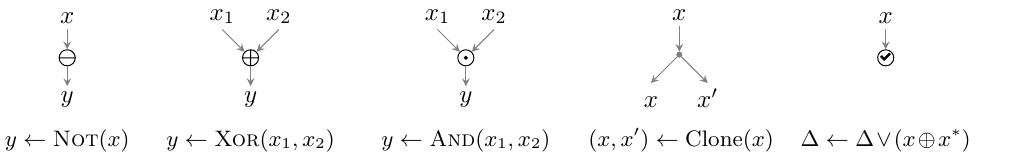
Figure 2: Nodes for basic circuits in the computation graph